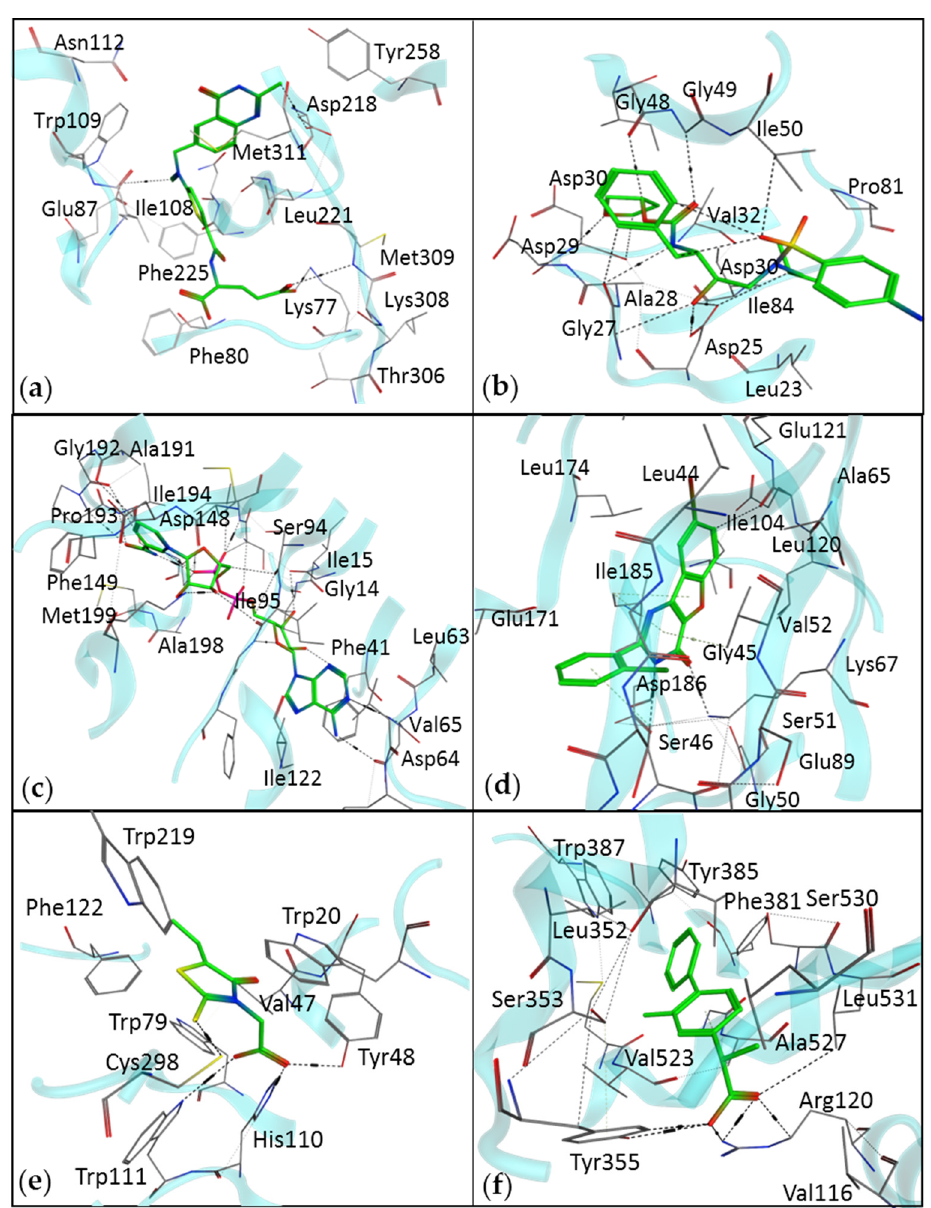
Figure 2. The interaction diagram of drugs identified by SBDD methods, with their respective therapeutic targets. ( a ) An interaction of raltitrexed with thymidylate synthase (Protein Data Bank (PDB) ID: 5X5Q). ( b ) An interaction of amprenavir with HIV protease (PDB ID: 3EKV). ( c ) Isoniazid, a drug for tuberculosis, identified by the SBVS method (PDB ID: 1ENY). ( d ) Pim-1 kinase inhibitor, benzofuropyrimidine, for the treatment of various types of cancers (PDB ID: 4ALU). ( e ) Epalrestat is an aldose reductase inhibitor (PDB ID: 4JIR). ( f ) Flurbiprofen is a cyclooxygenase 2 inhibitor (PDB ID: